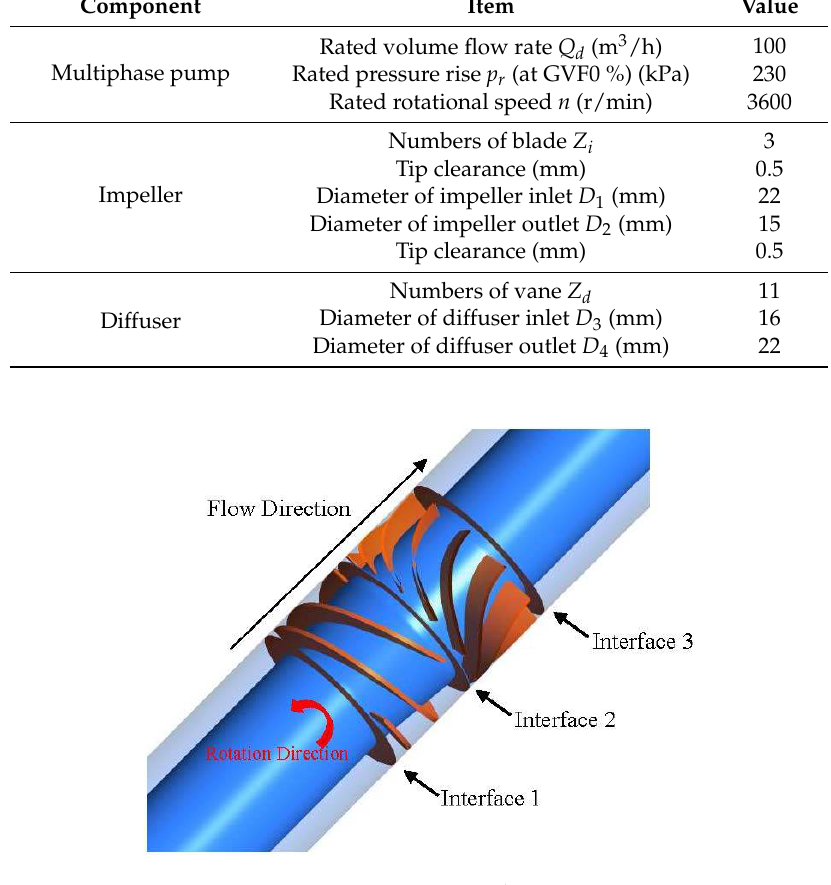
Figure 1. Computation domain.